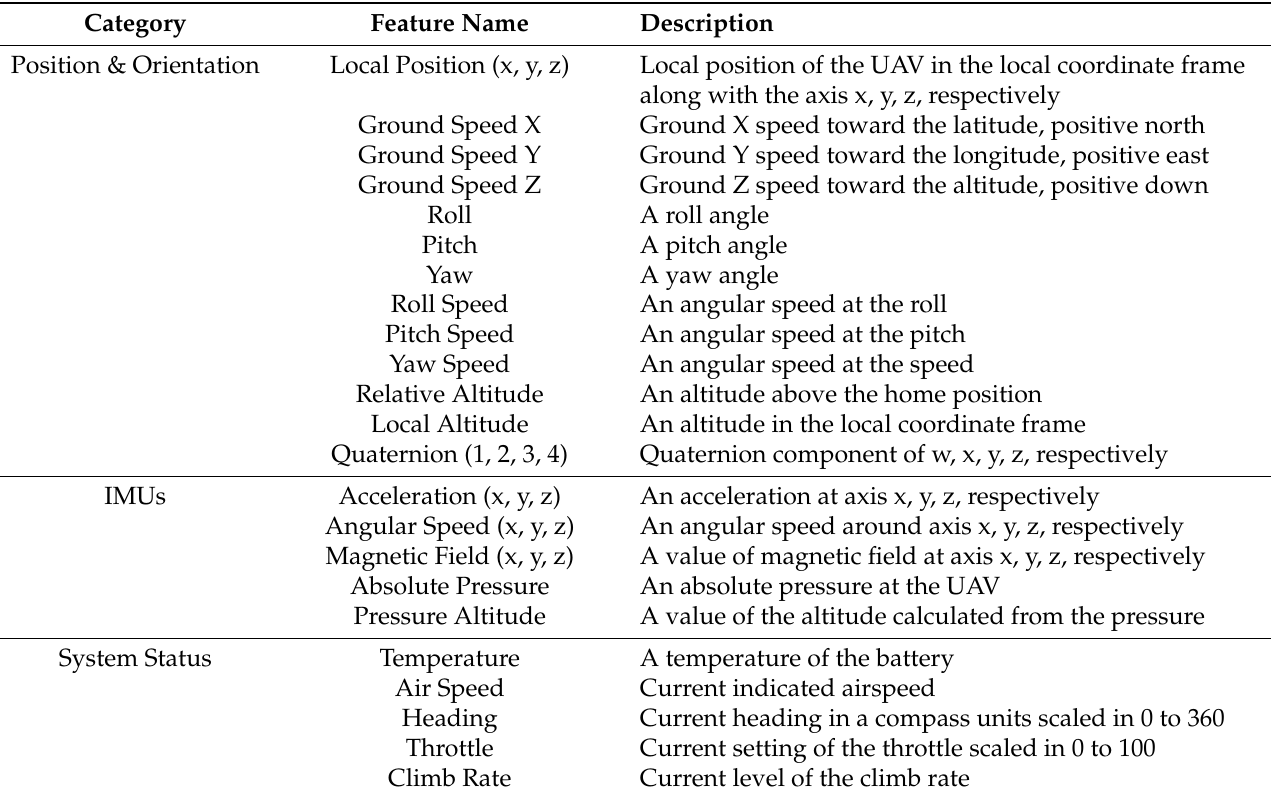
Table 1. Features extracted from the UAV Attack (UA)